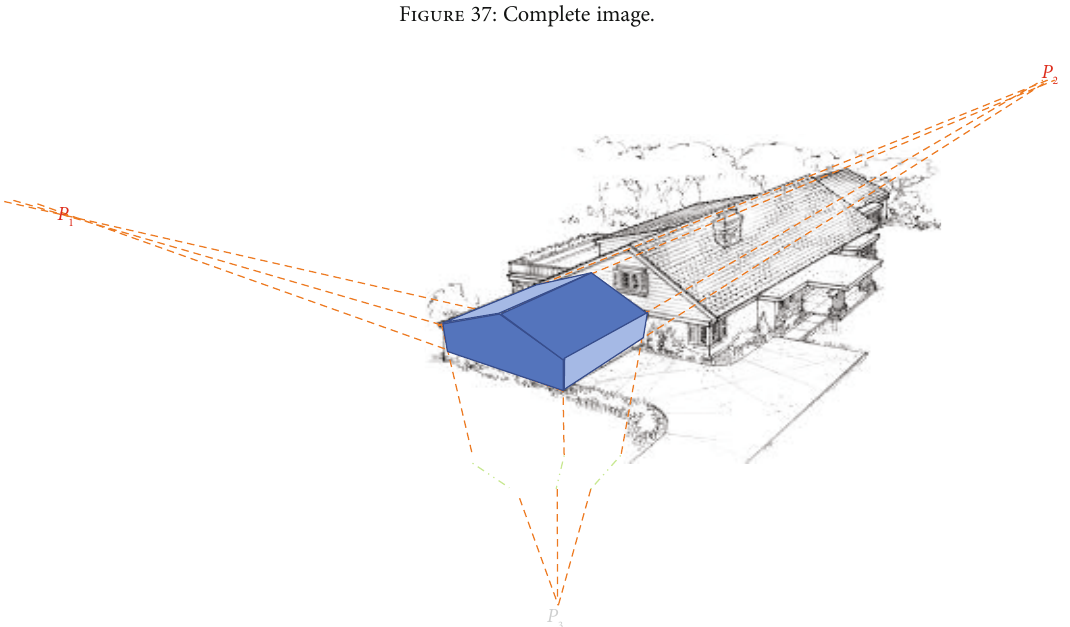
Figure 37: Complete image.